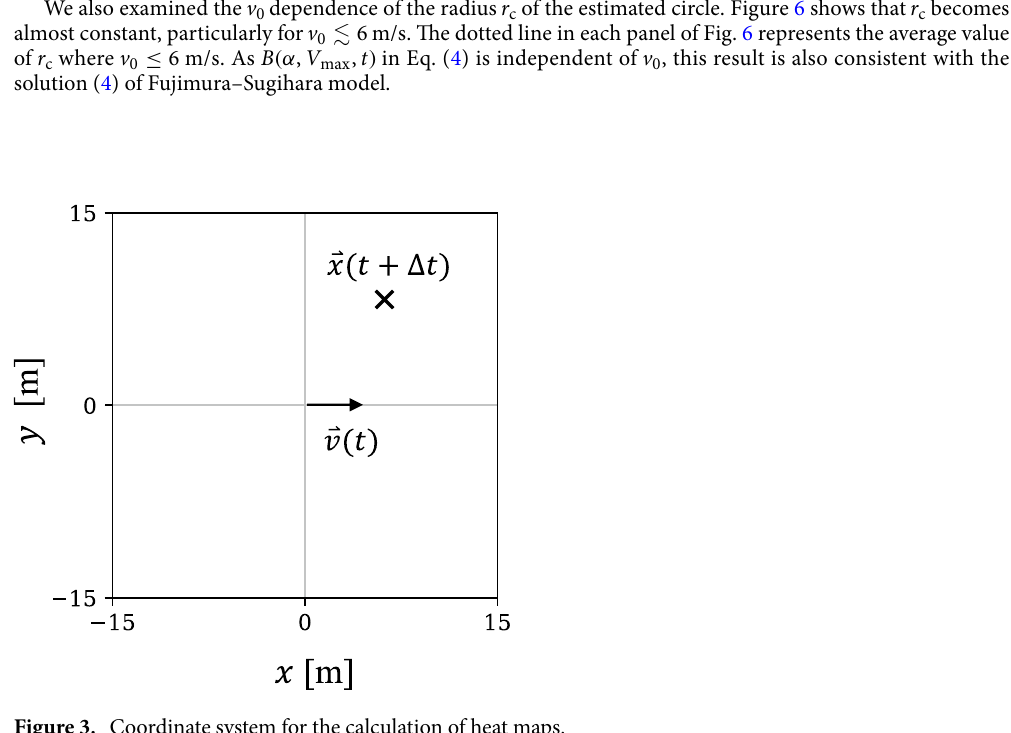
Figure 3. Coordinate system for the calculation of heat